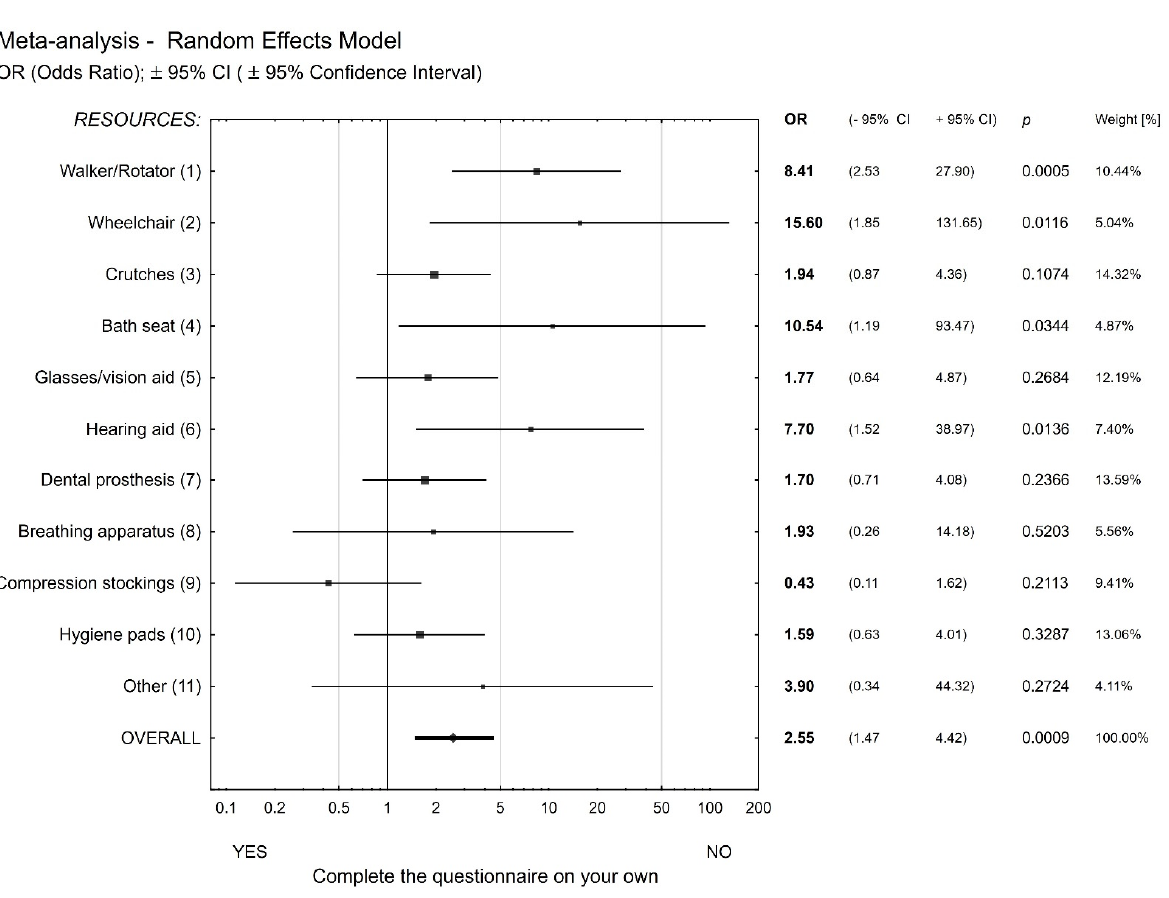
Figure 2. The use of assisting means versus the ability to complete the self-administered survey.